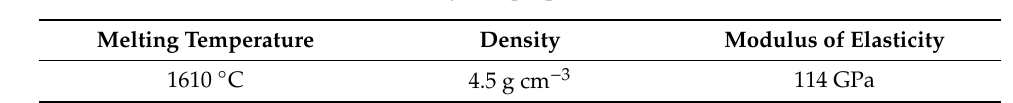
Table 3. Physical properties of Ti G4.